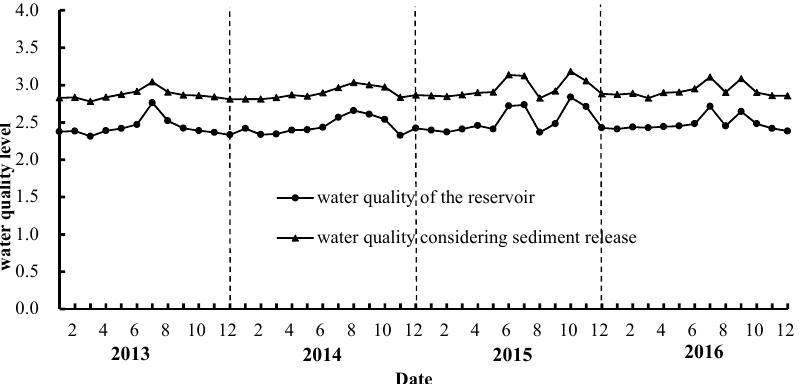
Figure 9. Water quality assessment results considering the release potential of sediments from 2013 to 2016 in Biliuhe reservoir.